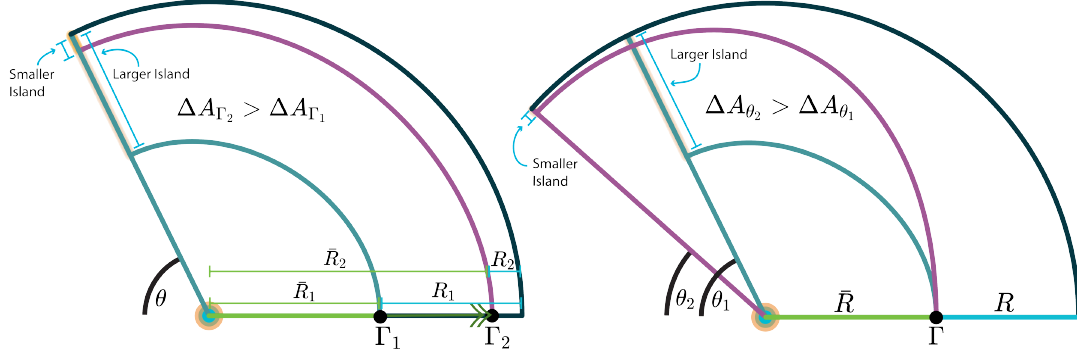
Figure 13 . Here we illustrate the Russian doll rule , which states that nested surfaces can be constructed by either decreasing the brane angle θ or increasing the anchor point Γ . This always b pushes the surfaces closer to the event horizon into the bulk, decreases the size of the island on the brane, and increases the area difference between the island surface and the HM surface on the initial time slice. The area difference increases without bound as the event horizon is approached by the island surface.